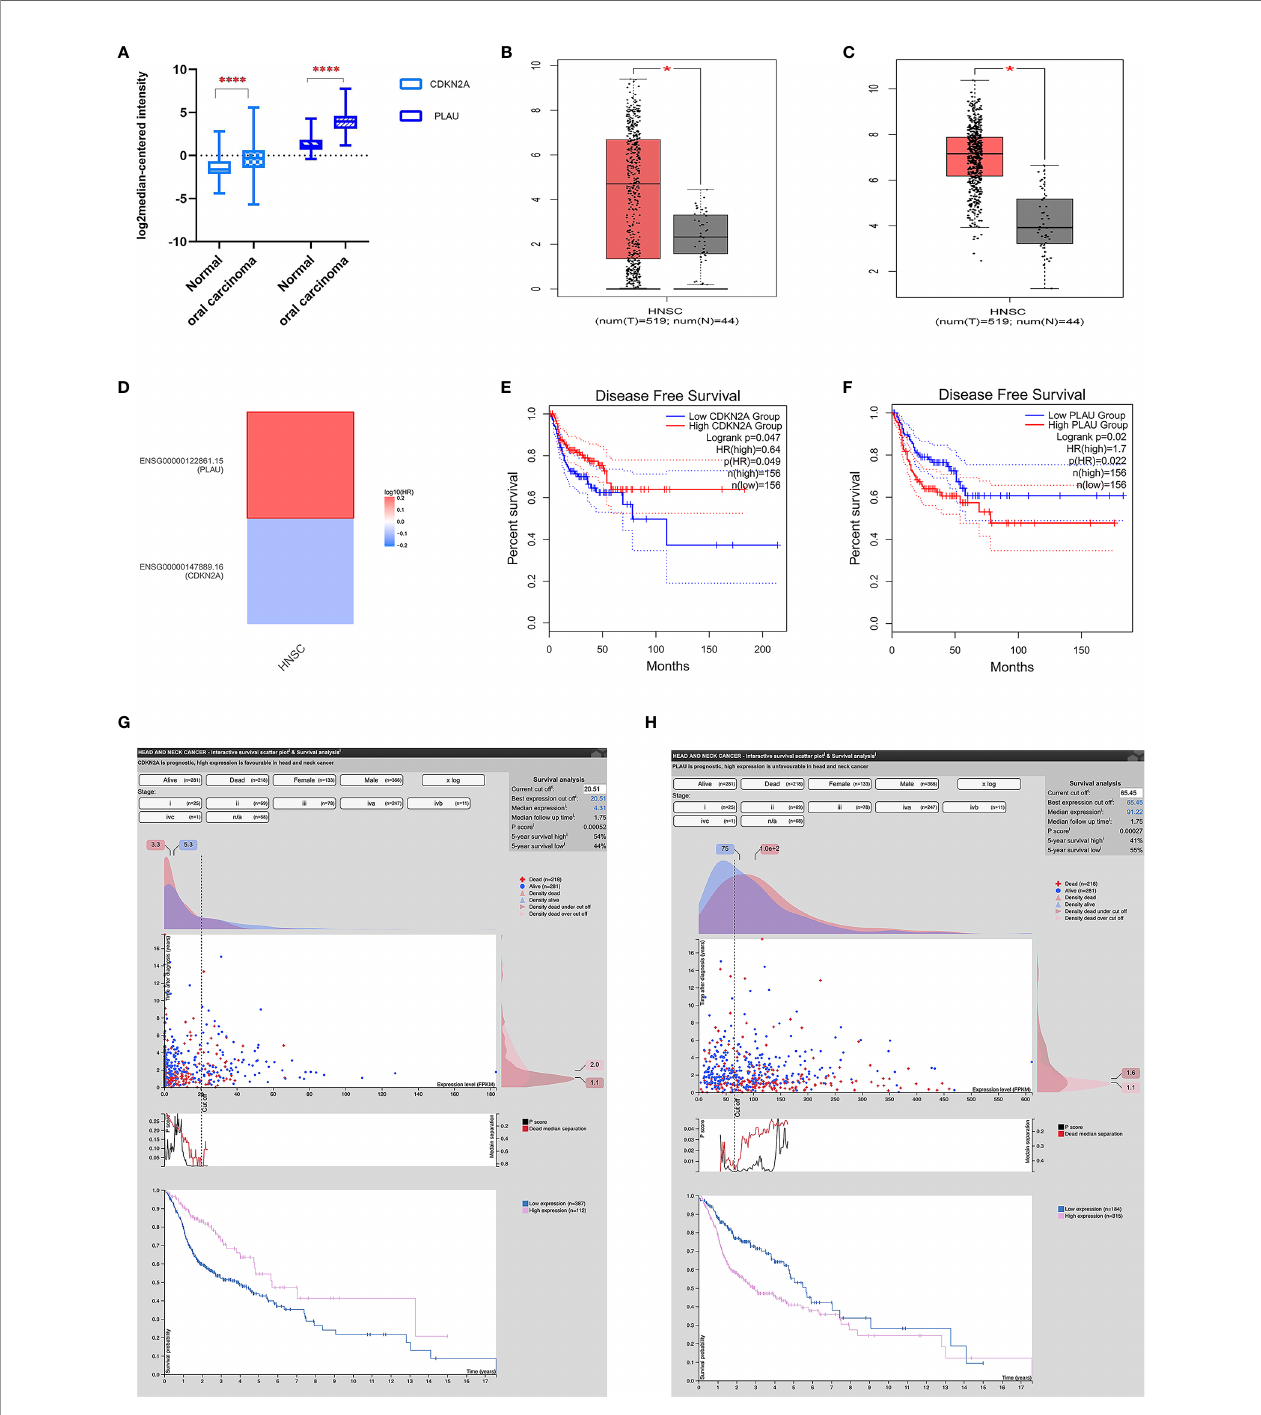
FIGURE 2 | The expression of CDKN2A and PLAU and their survival signi fi cance in HNSCC from an online database. (A) mRNA expression of CDKN2A and PLAU in OSCC and normal tissues from the Oncomine database; (B) mRNA expression of CDKN2A in HNSCC from the GEPIA database; (C) mRNA expression of PLAU in HNSCC from the GEPIA database; (D) survival map displaying the prognostic signi fi cance of CDKN2A and PLAU expression in HNSCC; (E) CDKN2A mRNA expression and disease-free survival; (F) PLAU mRNA expression and disease-free survival; (G) interactive survival scatter plot and 5-year overall survival according to different CDKN2A protein expression; (H) interactive survival scatter plot and 5-year overall survival according to different PLAU protein expression. *P < 0.05; ****P <